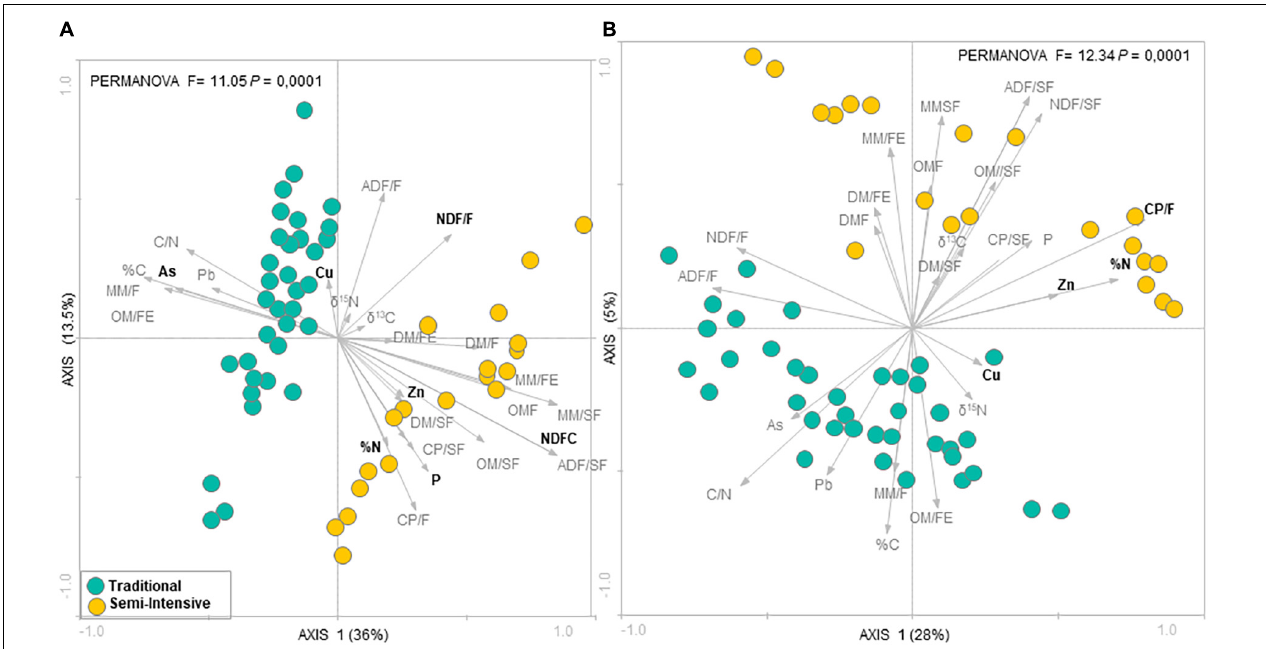
FIGURE 1 | Redundancy analysis (RDA) of the fecal microbial communities at (A) genus level and (B) functional profile in beef cattle from semi-intensive (yellow) and traditional (blue) systems. Arrows indicate correlation between environmental parameters and community structure. Bold letters indicate significant correlations evaluated via the Monte Carlo permutation test ( P <